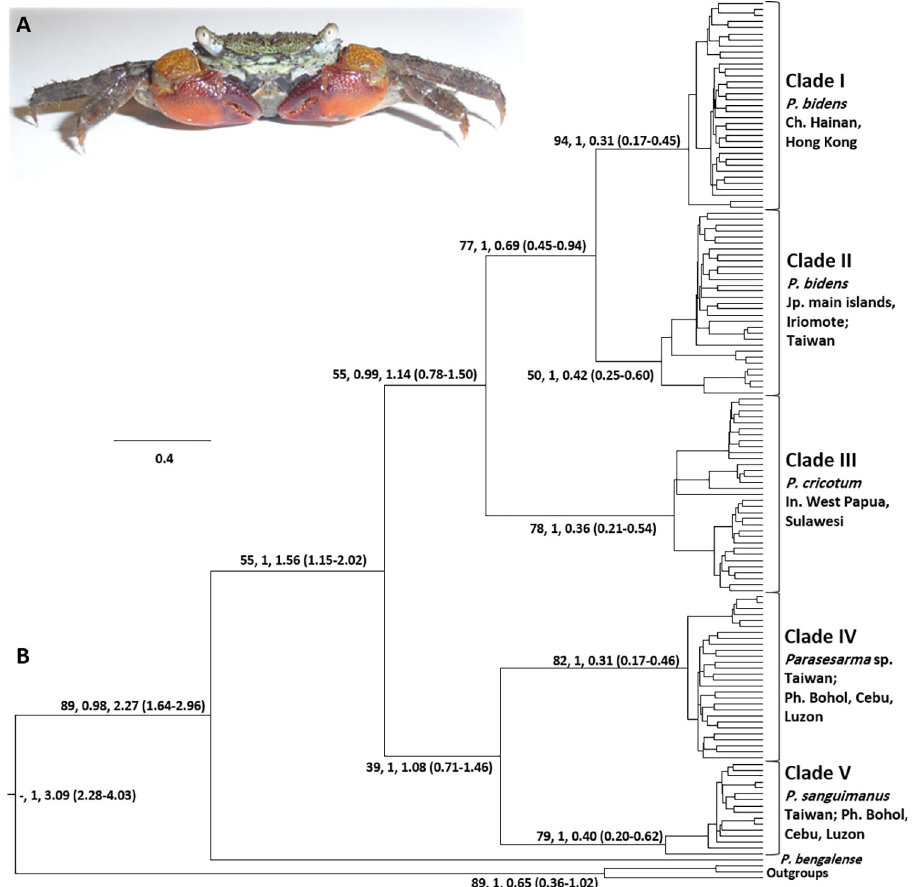
Fig 2. BI tree. A. Specimen of Parasesarma bidens from Hainan (China) with live colours. B. COX1 (742 bp of the 3’ end) consensus Bayesian tree topology constructed with BEAST. Values on tree branches from left to right refer to bootstrap values in ML, posterior probabilities in BI, and estimated divergence time [ranges in parenthesis], respectively for each corresponding node. P . eumolpe , P . indiarum and P . peninsulare were selected as outgroups. Abbreviations: Ph, Philippines; Ch, China; Jp, Japan; In, Indonesia.